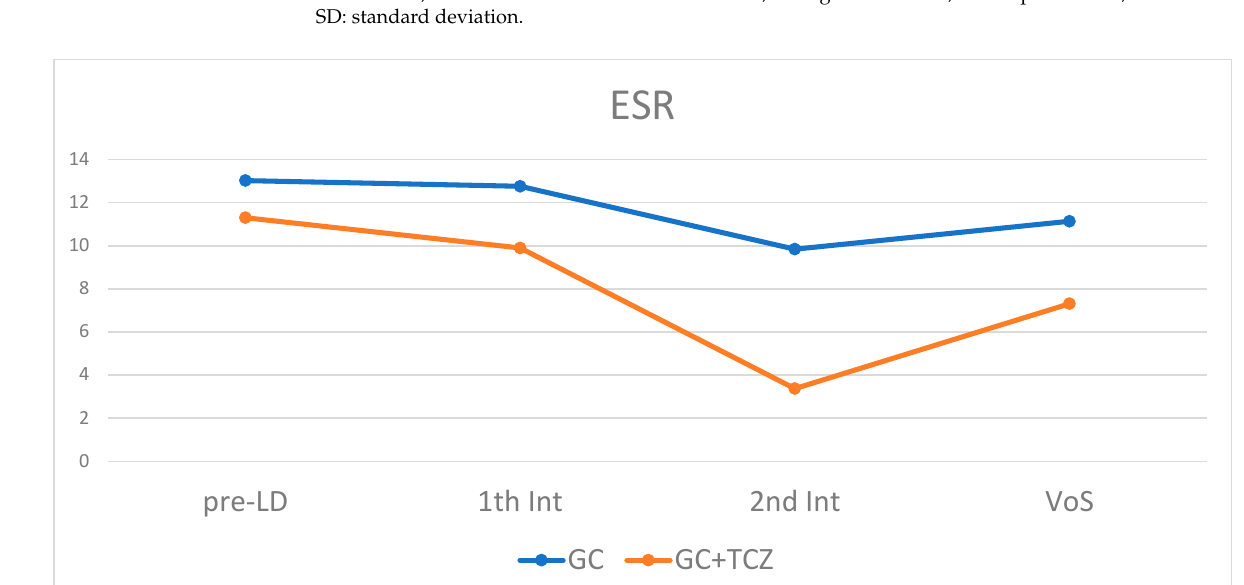
Figure 2. CPR trend during monitoring in the two di ff erent groups of patients treated with and without TCZ. CRP: C-reactive protein; GC: glucocorticoid; TCZ: tocilizumab; pre-LD: pre-lockdown visit; 1th Int: fi rst interview; 2nd Int: second interview; VOS; visit on site.